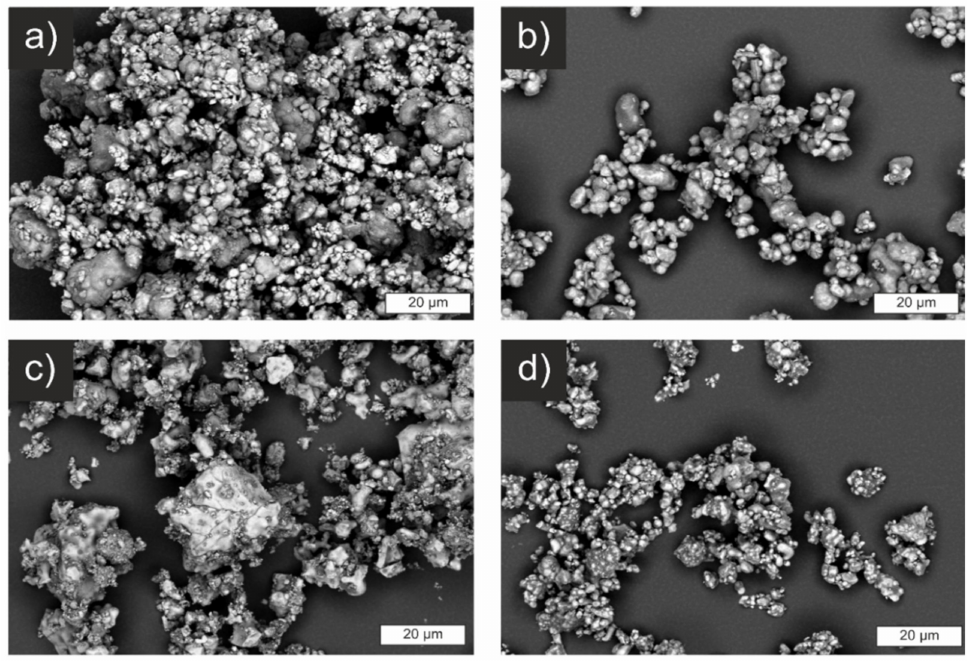
Figure 5. Scanning electron micrographs of samples prepared by different synthesis routes. ( a ) SSR, ( b ) SASSR, ( c ) CP, and ( d )